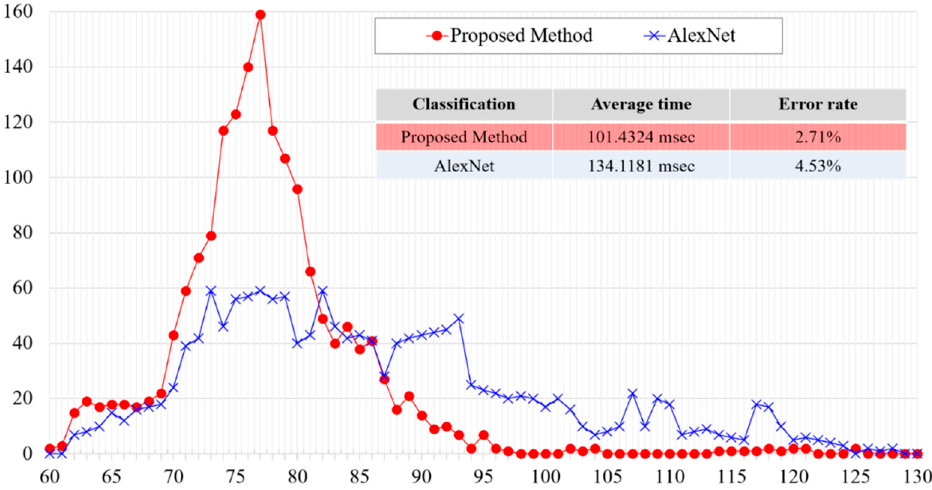
Figure 12. Face area detection time (in milliseconds).